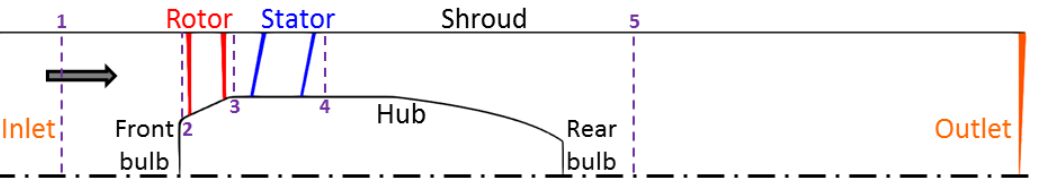
Figure 4. Meridional view of the computational domain.